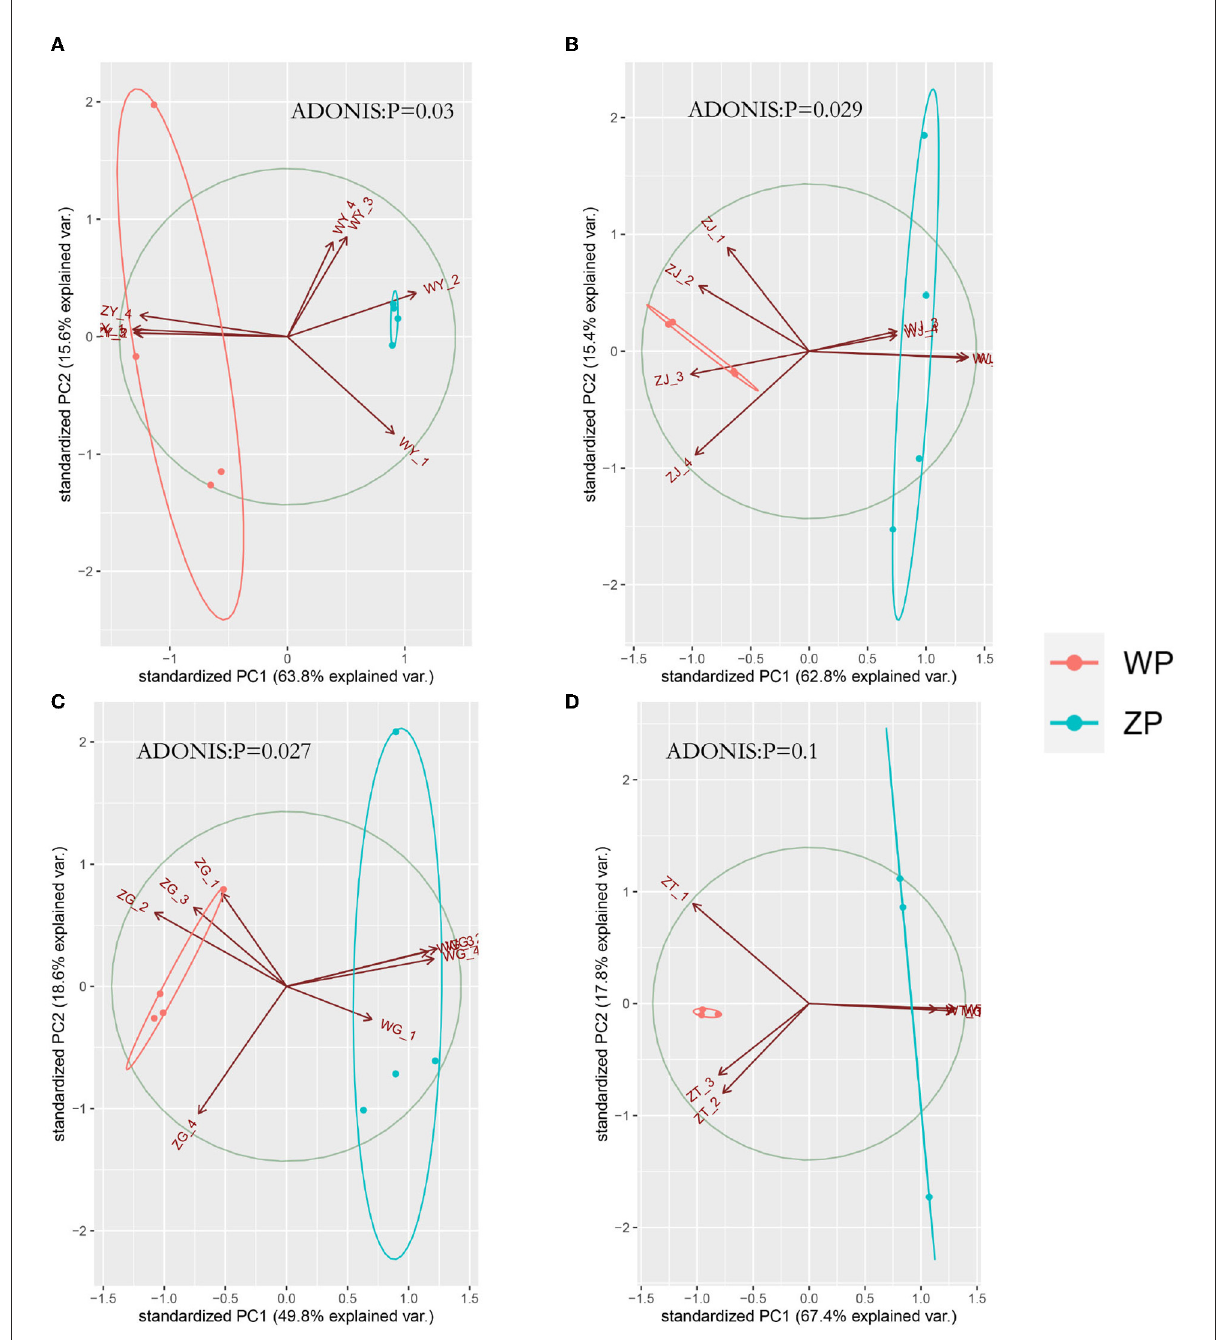
FIGURE5 PCA analysis of three compartments between ZP and WP [ (A) leaf, (B) stem, (C) root, (D) rhizosphere soil].